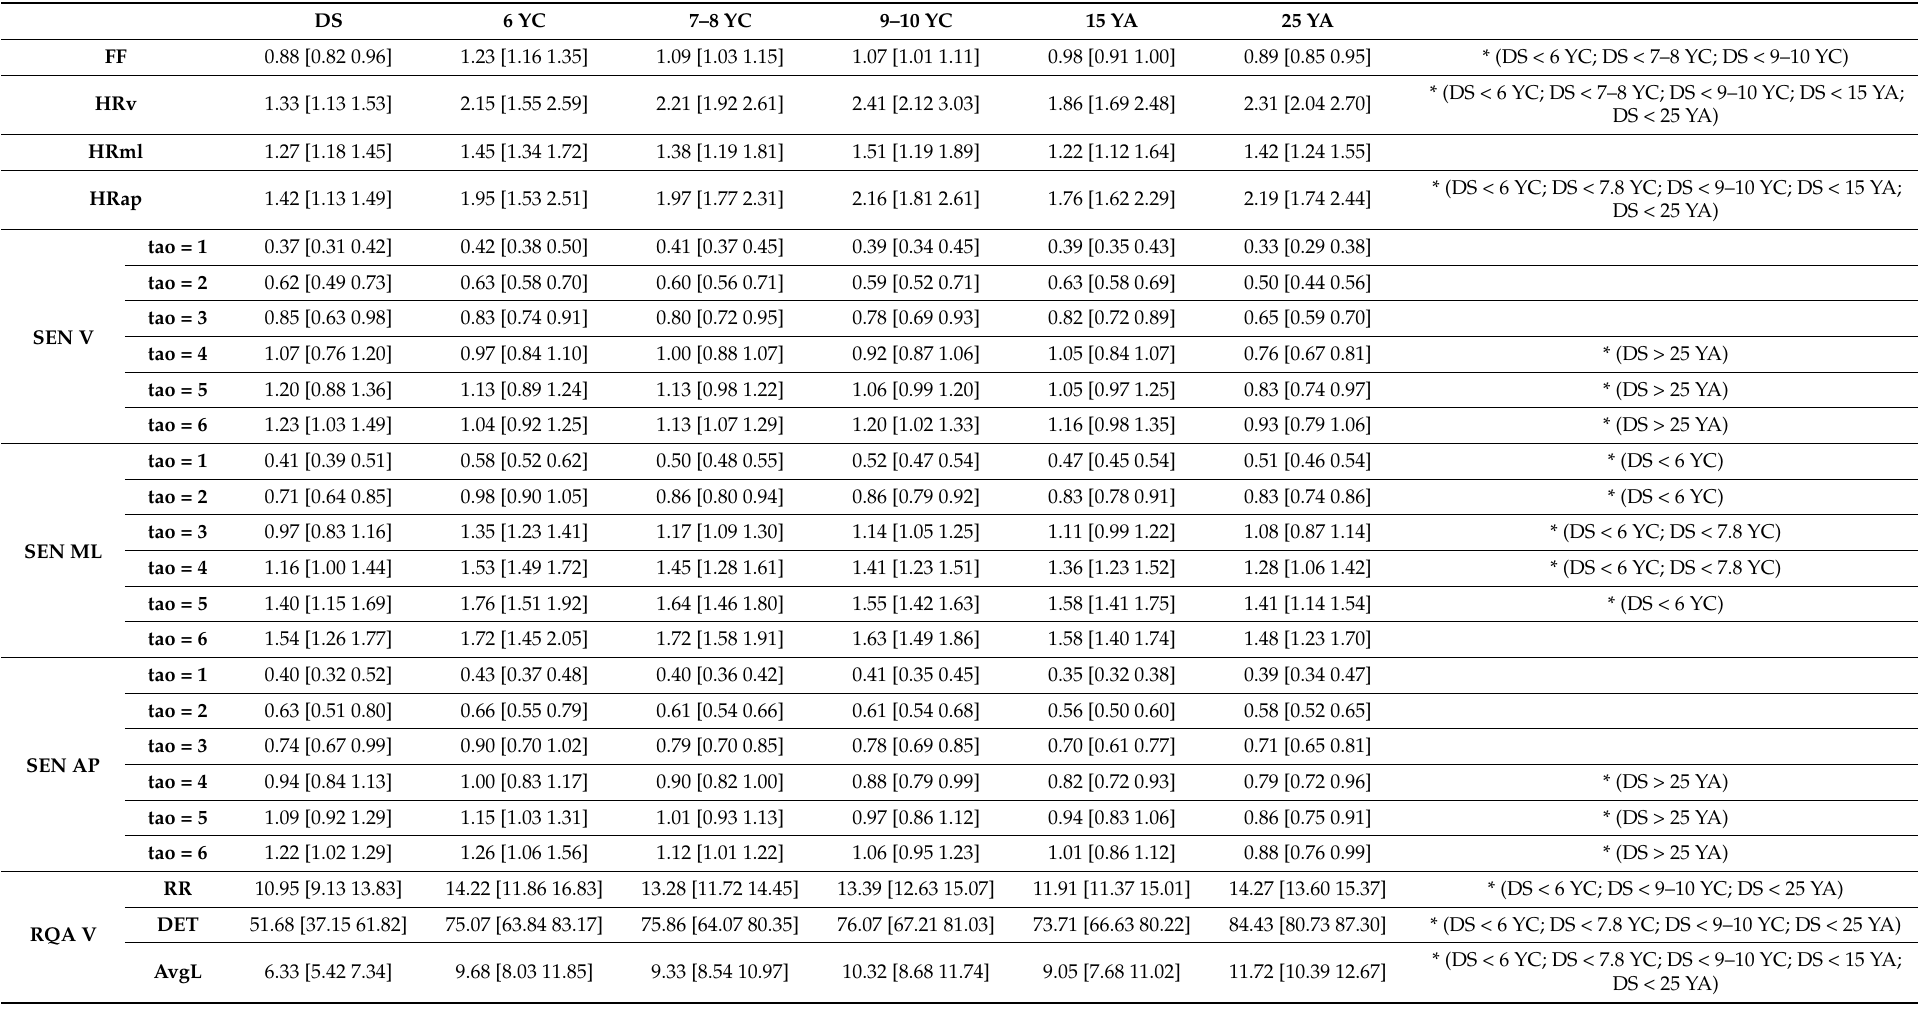
Table 5. Median (25th and 75th percentile) values of estimated nonlinear parameters for DS, TD, and specific TD age groups (6 YC, 7–8 YC, 9–10 YC, 15 YA, and 25 YA). Asterisks indicate significant differences, described between